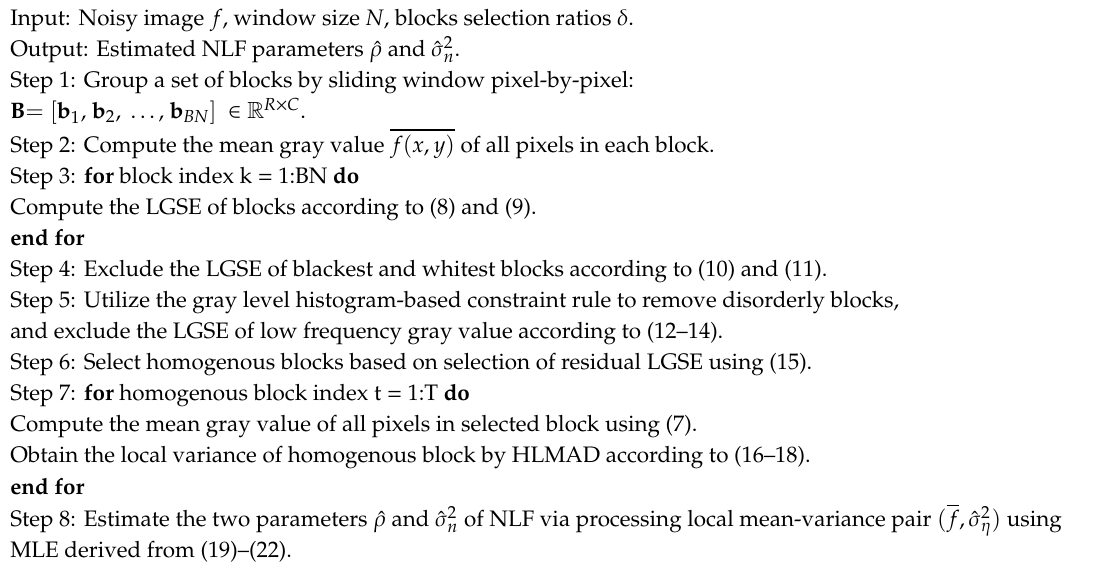
Algorithm 2. Proposed noise parameter estimation algorithm for the PGN